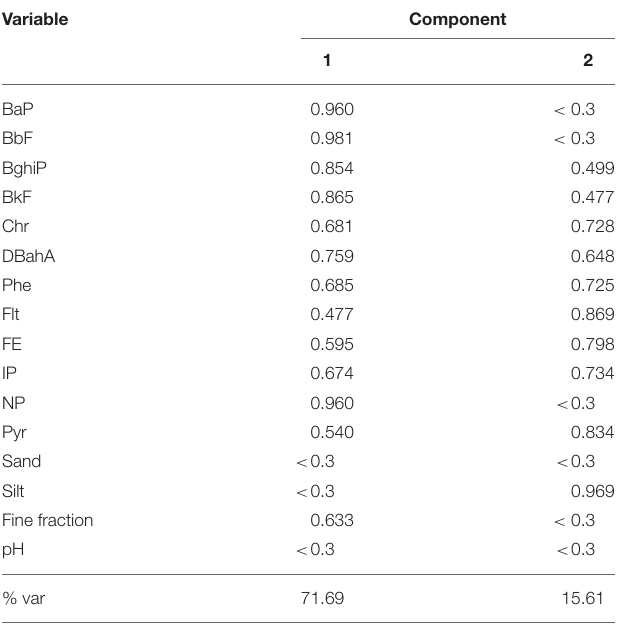
TABLE 6 | Factor loadings of the rotated component matrix for the soil (% var, % of variance).